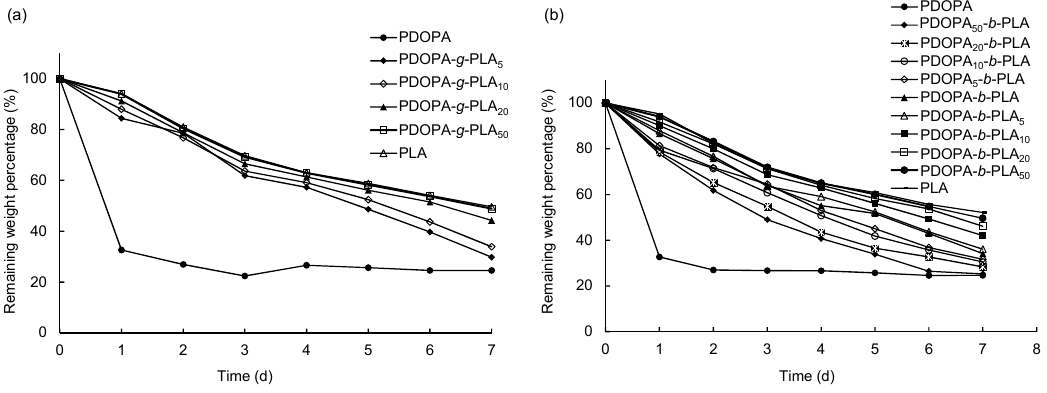
Figure 4. Remaining weights of PDOPA- g -PLA ( a ) and PDOPA- b -PLA ( b ) with degradation time in buffer solution at pH 10.2.